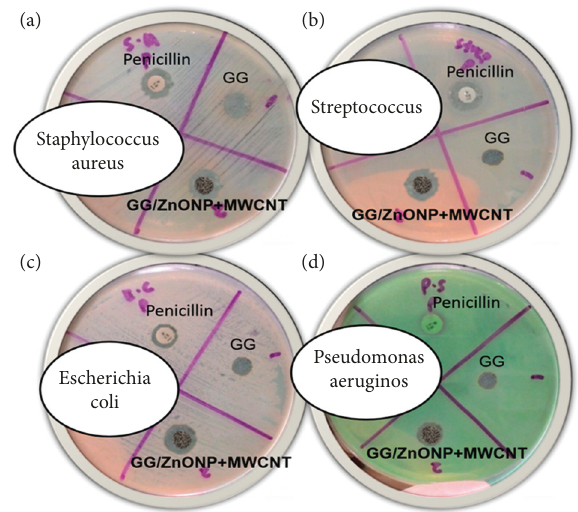
Figure 7: Agar well diffusion test results of control sample (peni- cillin), pure GG, and GG/ZnONP+MWCNT bionanocomposite films against (a) Staphylococcus aureus , (b) Streptococcus , (c) Escherichia coli , and (d) Pseudomonas aeruginosa